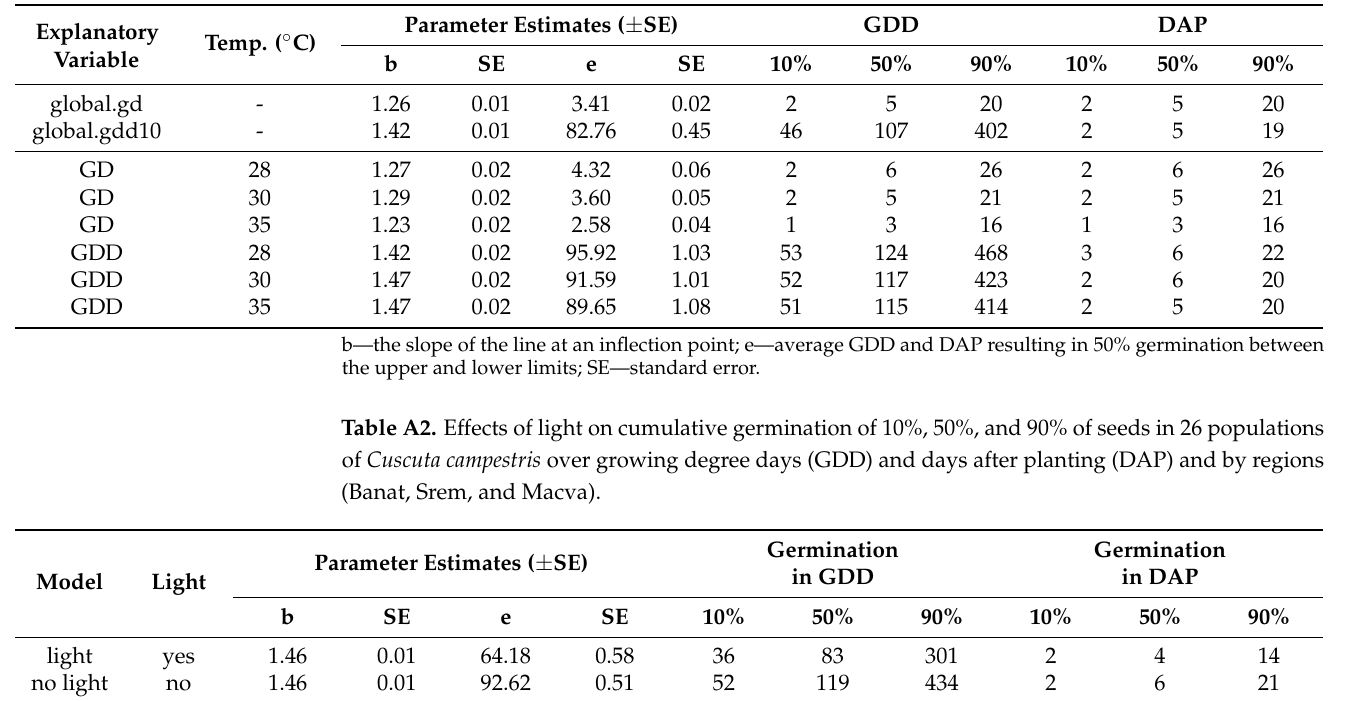
Table A1. Effects of temperature on cumulative germination of 10%, 50%, and 90% of seeds in 26 populations of Cuscuta campestris over growing degree days (GDD) and days after planting (DAP).